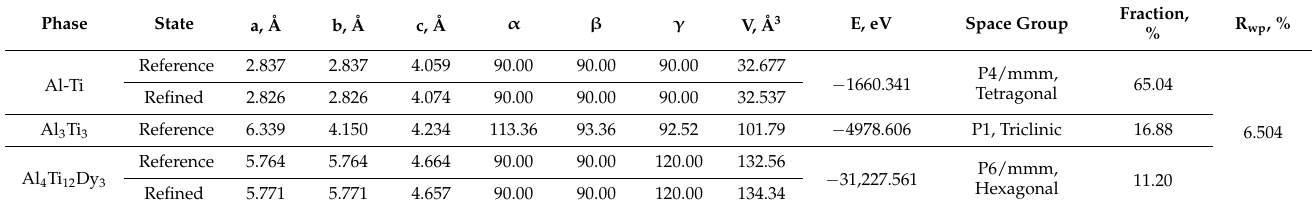
Table 2. Structural parameters of the lattices in the TAD